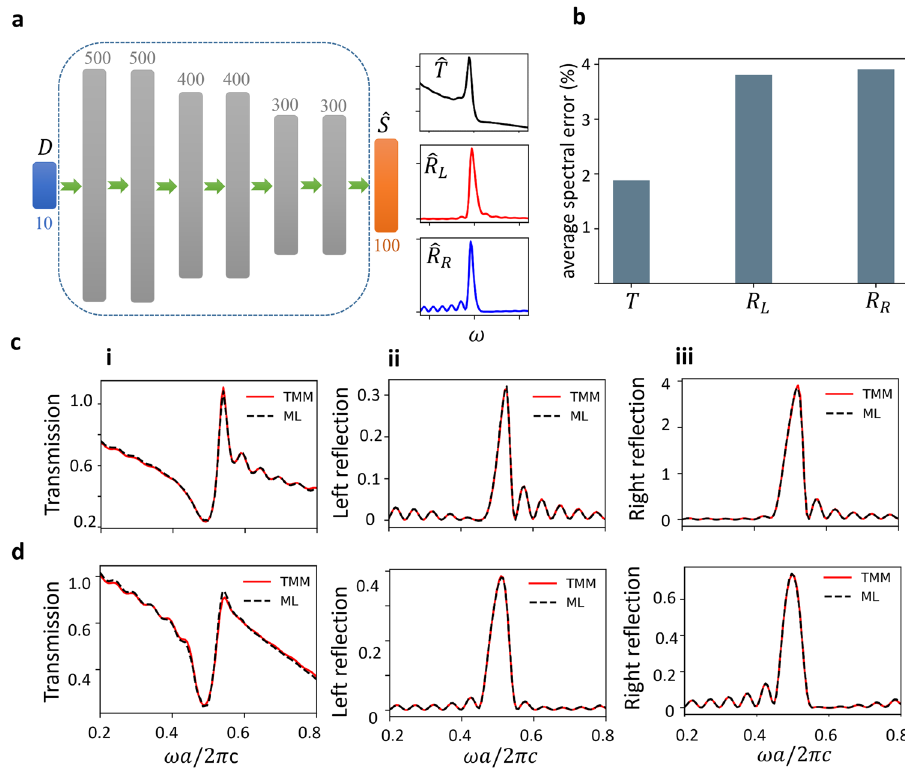
Fig. 4 Designed feed forward neural network for non-Hermitian structures. a Architecture of the 6-layer neural network with input D and output ^ S , with the transmission ^ T , left re fl ection ^ R L , and right re fl ection ^ R R versus frequency ω . b Average spectral prediction error for transmission and left/right re fl ection. c , d Representative examples of the predicted spectral response (using Transfer Matrix Method: TMM and Machine Learning: ML) for the designed networks (i) transmission, (ii) left re fl ection, and (iii) right re fl ection versus normalized frequency ω a /2 π c , with a the dimension of the scatterer and c the speed of light in free